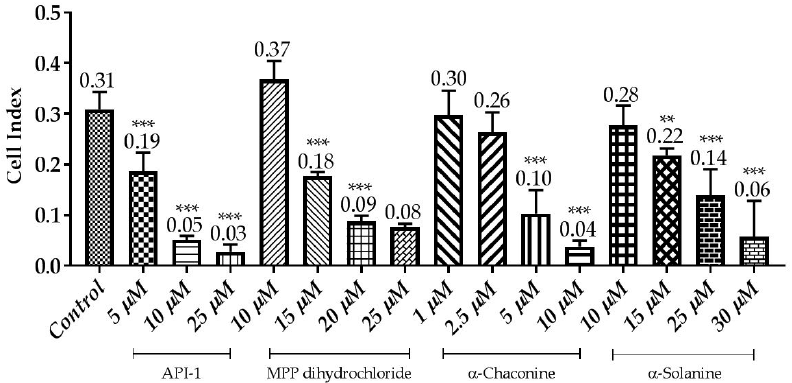
Figure 11. Correlation between cell index and the compounds effects using the xCELLigence